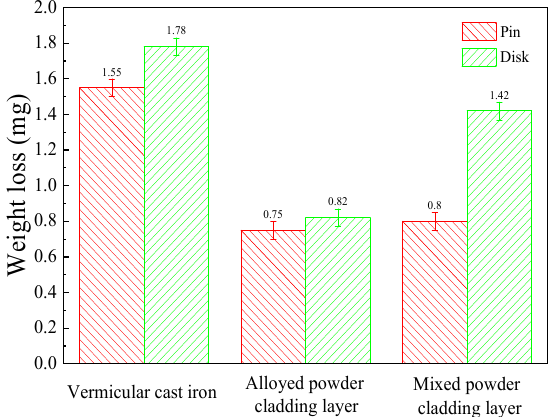
Figure 13. Weight loss of three friction pairs vs. sliding time at room temperature.